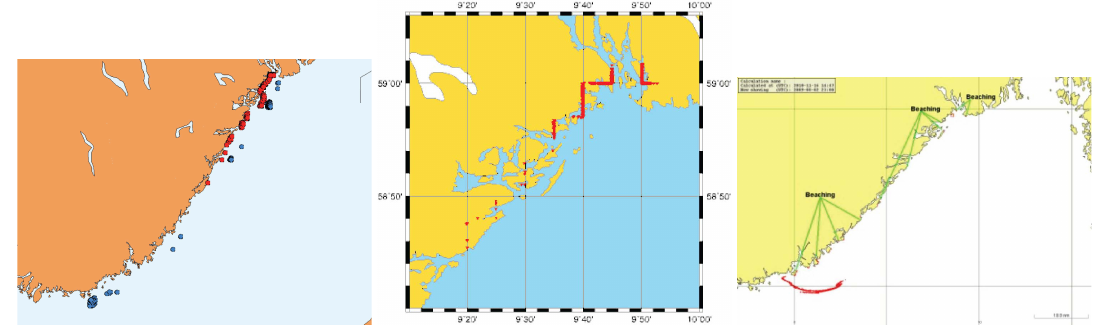
Fig. 11. Positions of the beaching of oil in the simulations presented in this study. The figure represents the oil 72h after the initial release of